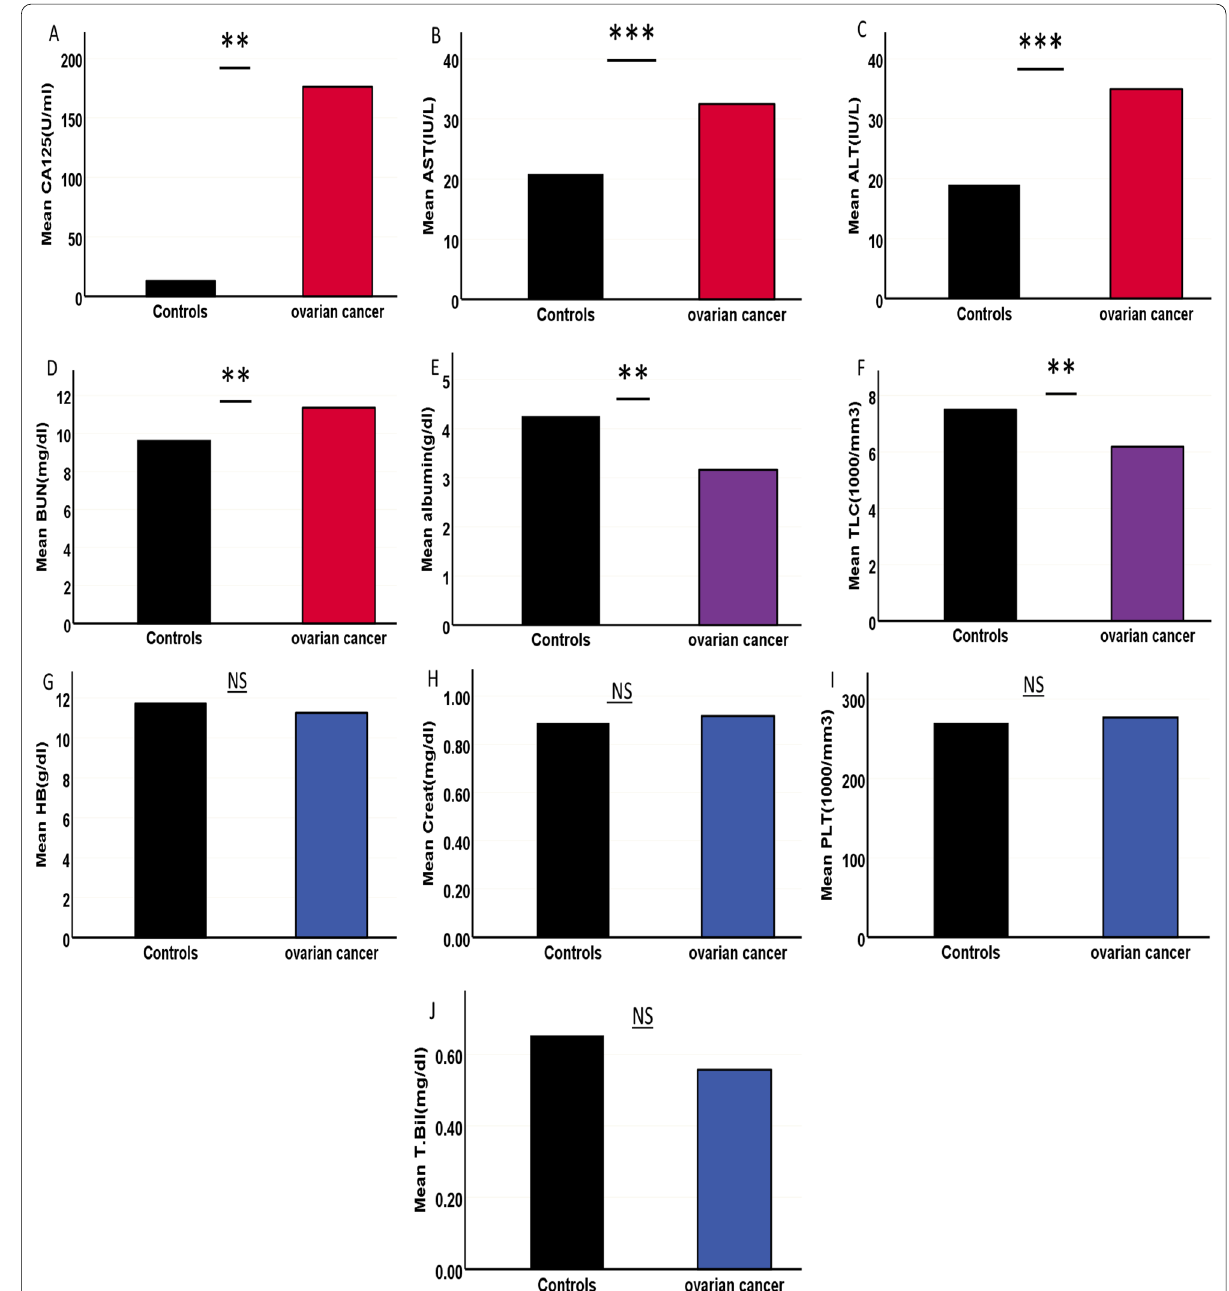
Fig. 3 Biochemical parameters compared to control and OC groups, with * P 0.05, ** P 0.01, and *** P 0.001 significance levels. Abbreviations: ALT, Alanine aminotransferase; AST, aspartate aminotransferase; CA125, cancer antigen 125; BUN, blood urea nitrogen; and TLC, total leucocytic